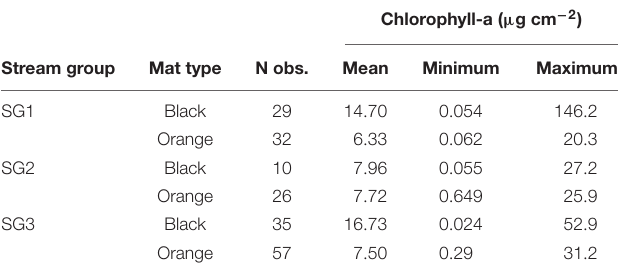
TABLE 3 | Summary of MCM LTER source data records used in metacommunity